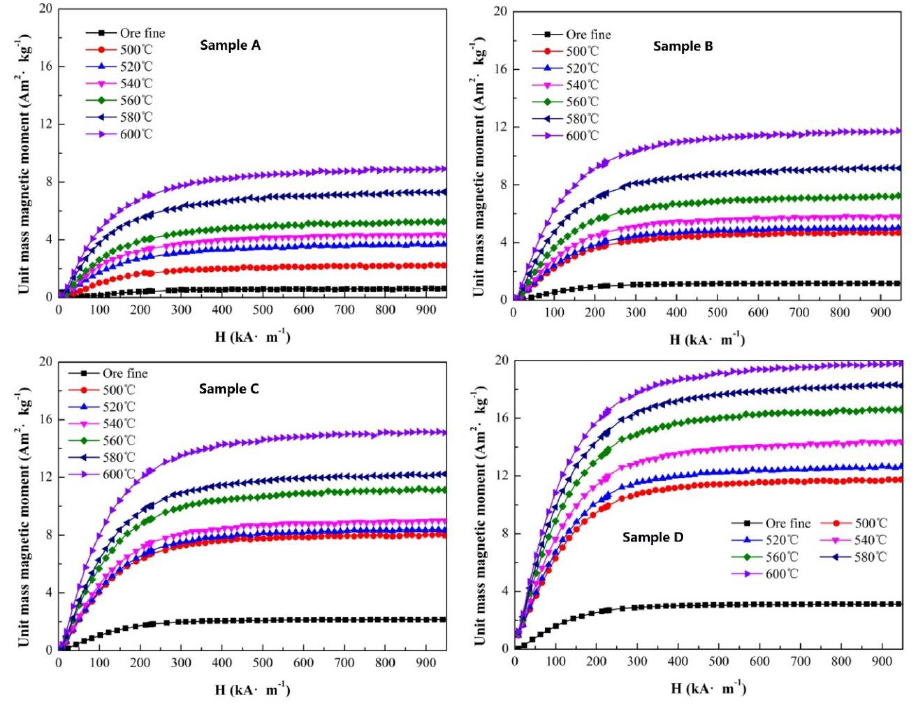
Figure 5. The unit mass magnetic moment of sample A to D with different roasting temperatures.